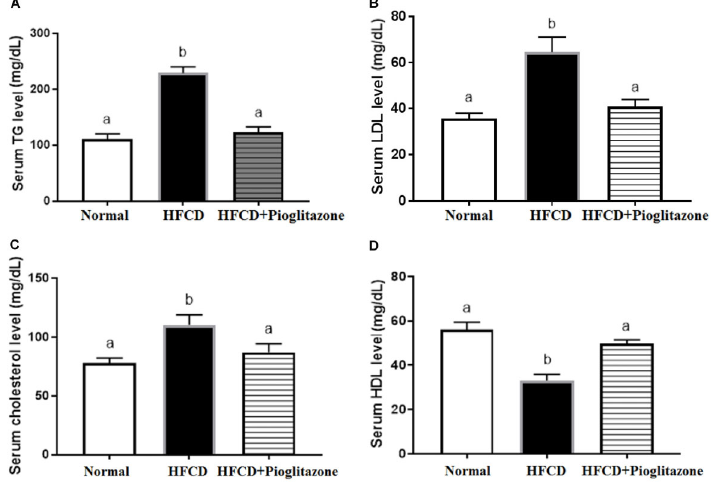
Figure 3. Changes in lipid biomarkers: triacylglycerol (TG), low-density lipoprotein (LDL), total cholesterol, and high-density lipoprotein (HDL) of normal, high fat-carbohydrate diet (HFCD), and HFCD + pioglitazone groups. Data are reported as mean ± SE. Different letters indicate a statistical difference among groups (P o 0.05,